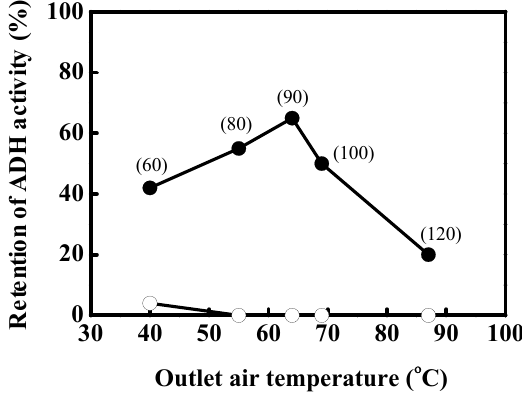
Figure 1. Effect of outlet air temperature on the retention of alcohol dehydrogenase (ADH) activity in spray-dried powders with mannitol ( ○ ) and the equal-mass mixture of mannitol and maltodextrin (MD) ( ● ). The value in the parenthesis is the inlet air